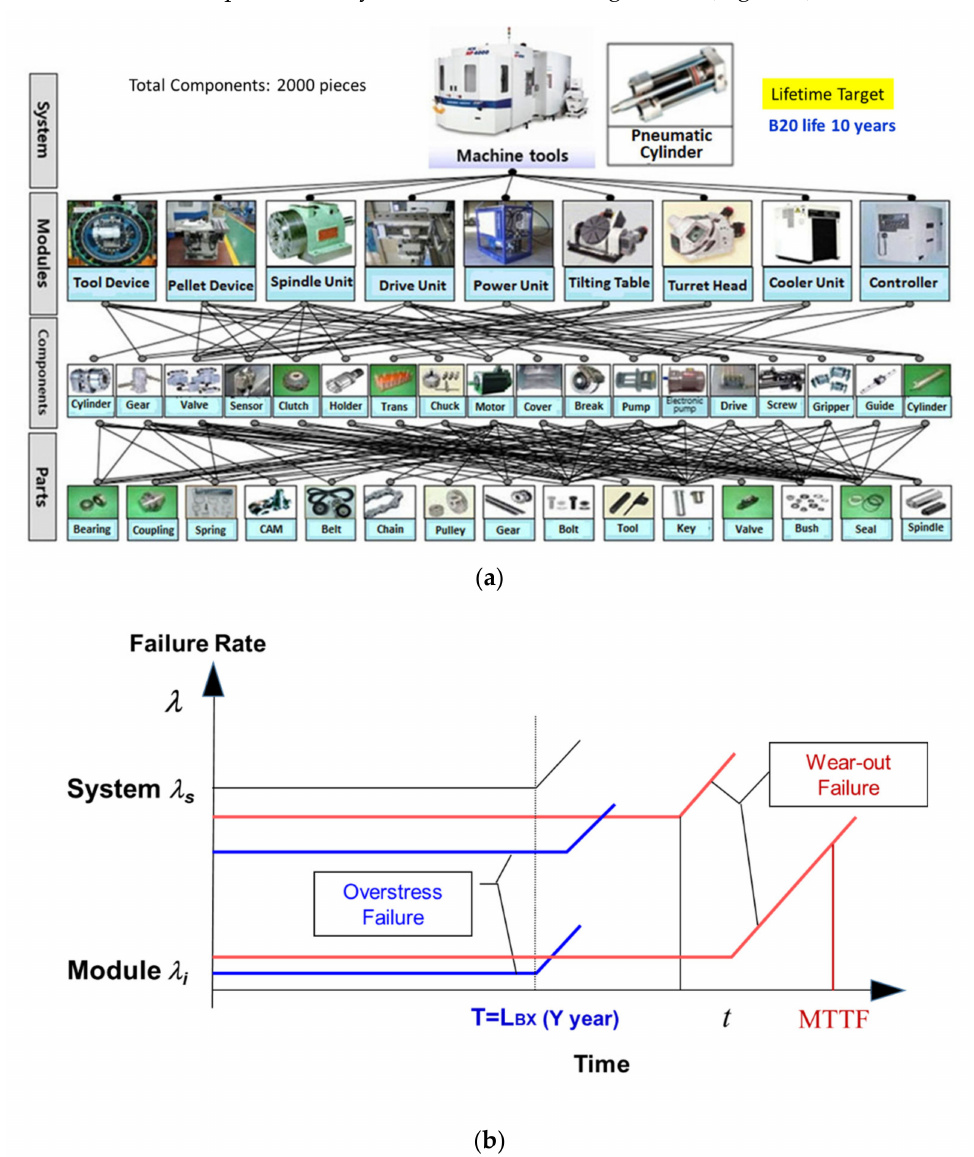
Figure 1. Product lifetime decided by newly designed module ( a ) categorization of multi-module machine center; ( b ) product lifetime L B